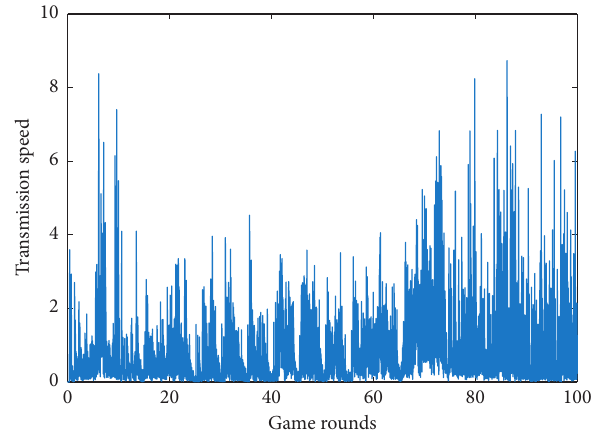
Figure 6: Changes in propagation speed with game rounds.